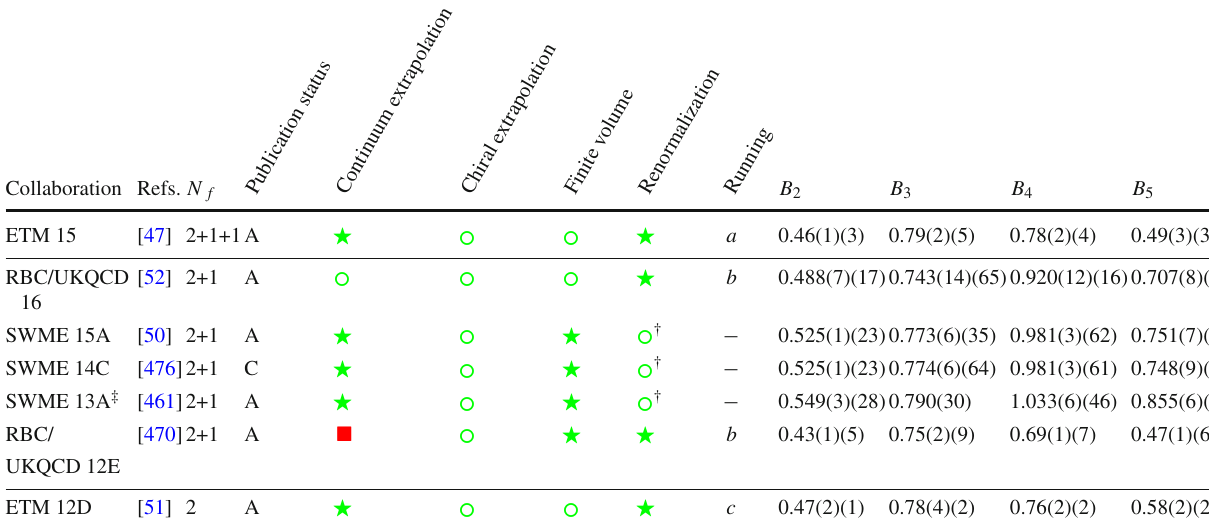
Table 33 Results for the BSM B -parameters B 2 ,..., B 5 in the MS scheme at a reference scale of 3GeV. Information about nonperturbative running is indicated in the column “running”, with details given at the bottom of the table.